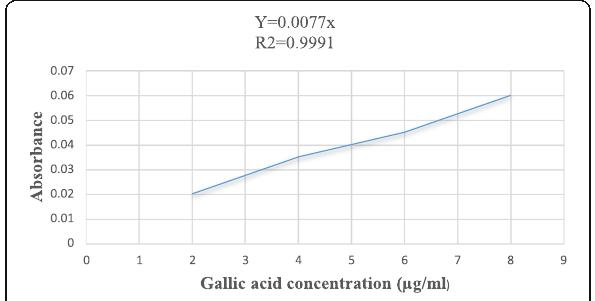
Fig. 2 Standard calibration curve of Gallic acid